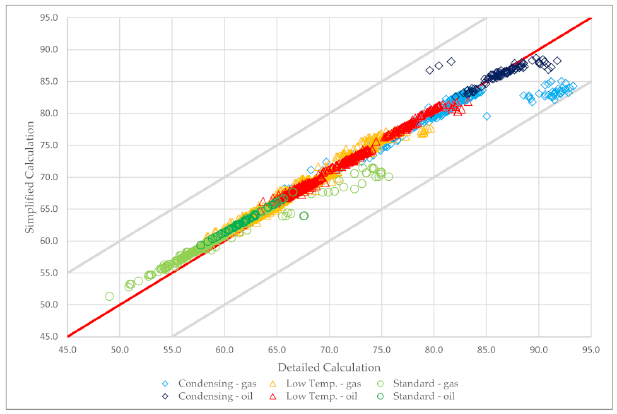
Figure 6. Comparison of seasonal heating efficiency of simplified and detailed